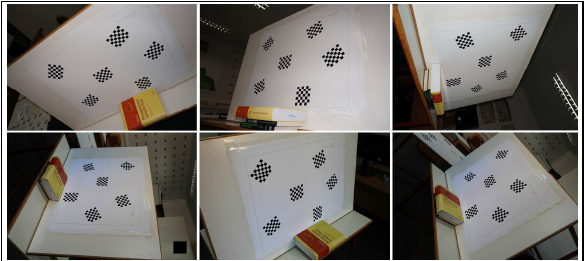
Figure 11. Images of the datasets (above: Sony; below: Canon).